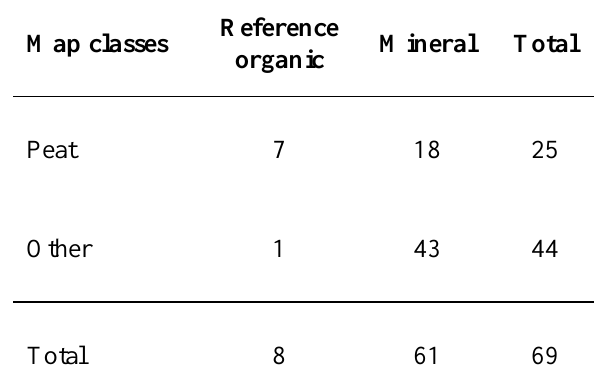
Table 1. Error matrix based on sample counts, where rows represent map classes and columns represent reference data